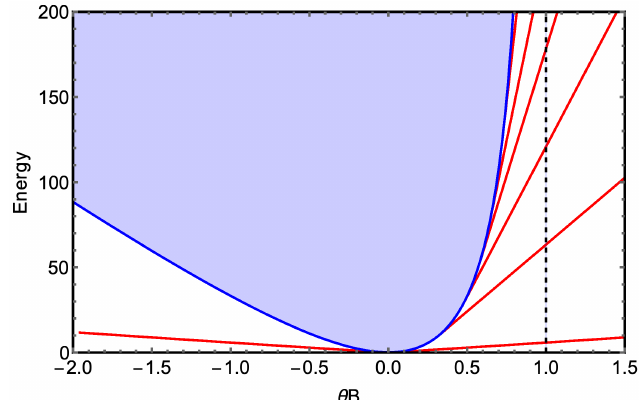
Figure 2: Energy spectrum as a function of magnetic field for the noncommutative hyperbolic plane. Blue shaded part corresponds to the continuum states. Red lines are Landau levels and the vertical black dashed line corresponds to θ B = 1.